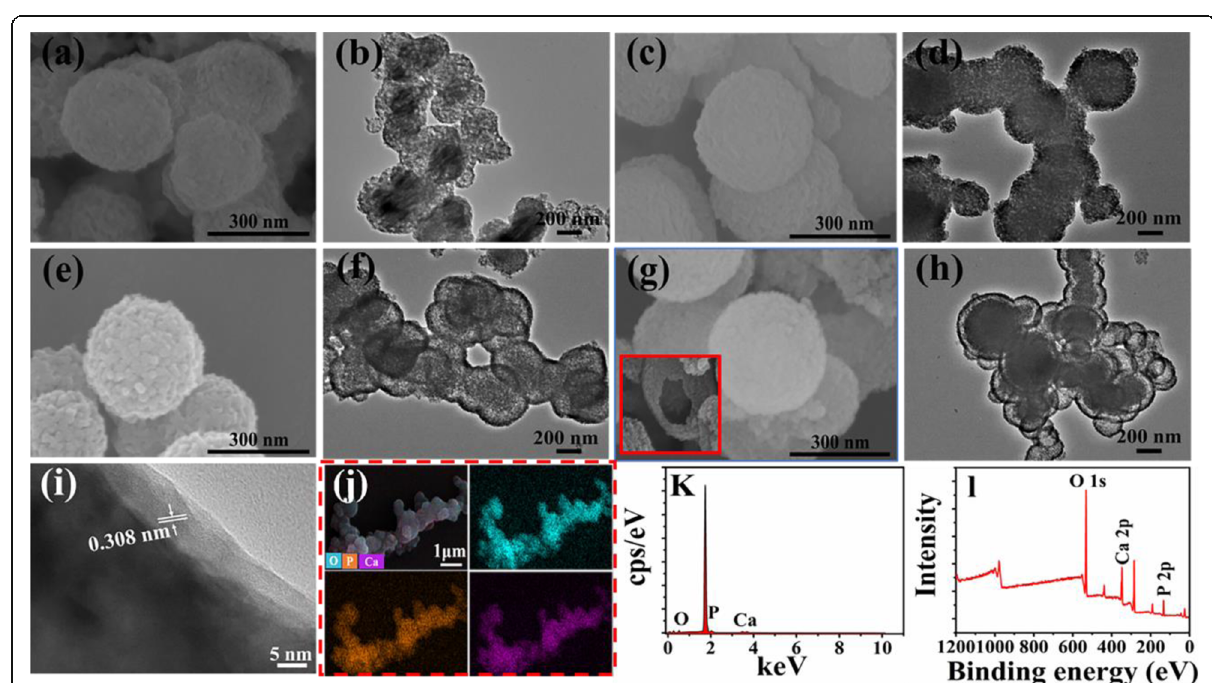
Fig. 3 SEM and TEM images of ATP-CG microspheres synthesized with various of Ca/P. a , b Ca/P = 0.8. c , d Ca/P = 1.67. e , f Ca/P = 2.5. g , h Ca/P